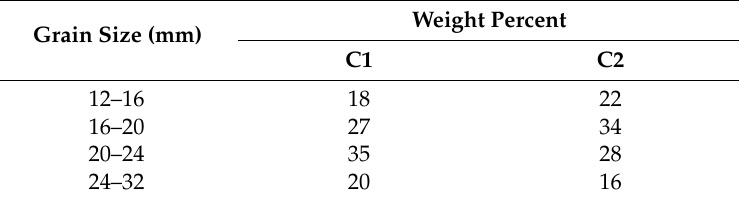
Table 4. Grain size gradation of coarse aggregates